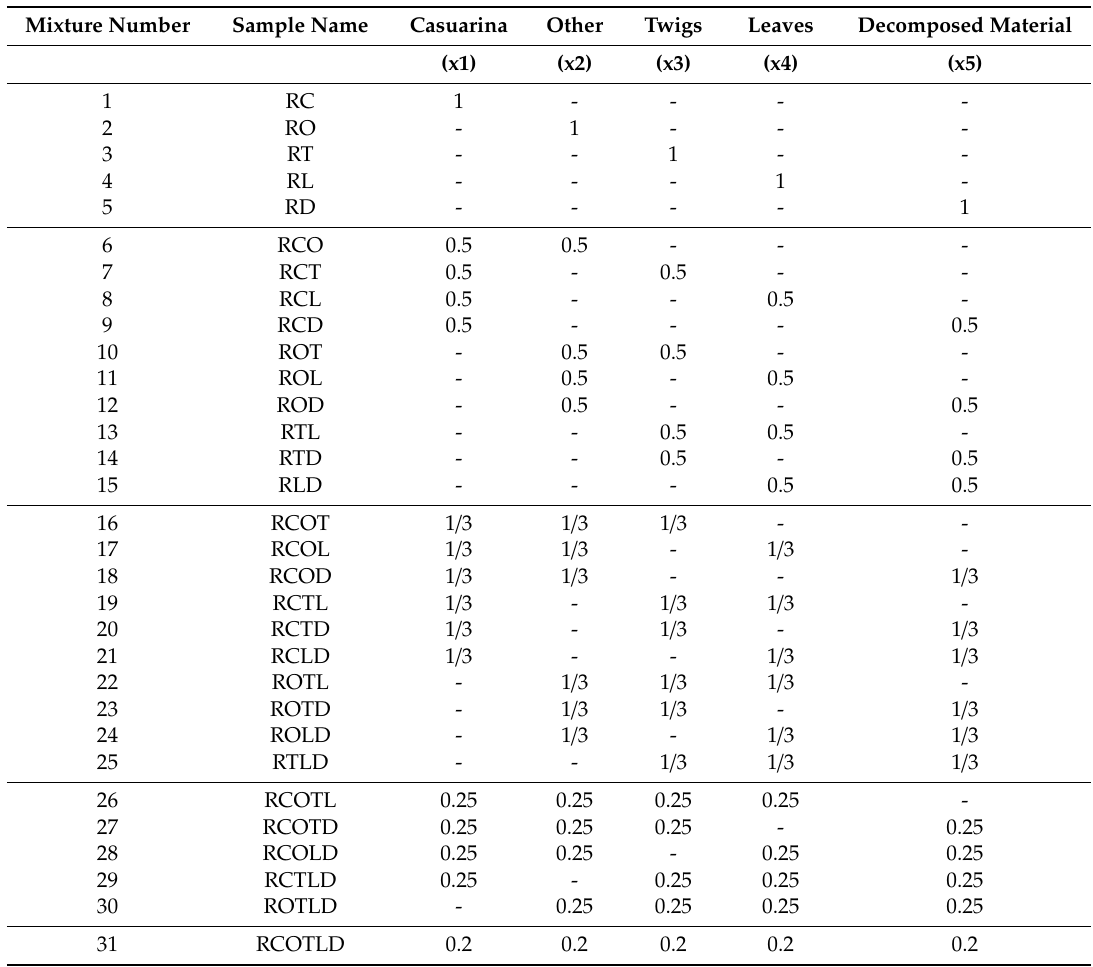
Table 2. Key to flammability combinations for litter from Rofe Park (R): Allocasuarina littoralis cladodes (C), other (O), twigs (T), leaves (L), decomposed material (D). The values represent the proportion of each litter component within a